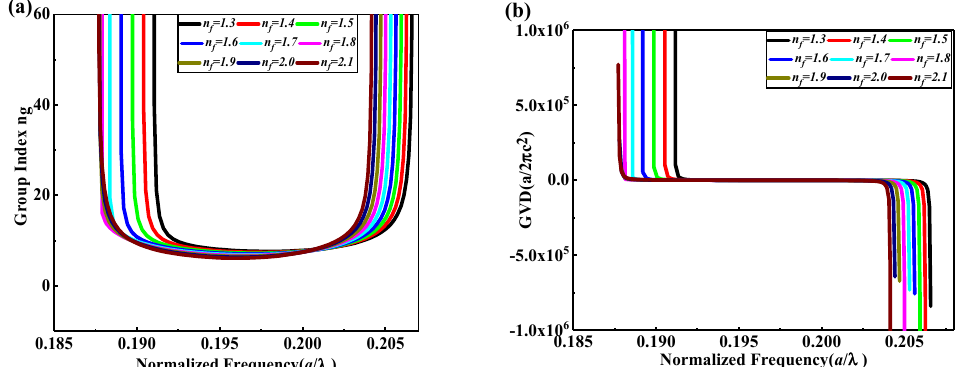
Figure 4. The magnetic field profile of pulse transmission inside the optimum structures for ( a ) S 1 at 𝑙 = 1.25𝑎 and ( b ) S 2 at 𝑙 = 1.725𝑎 .